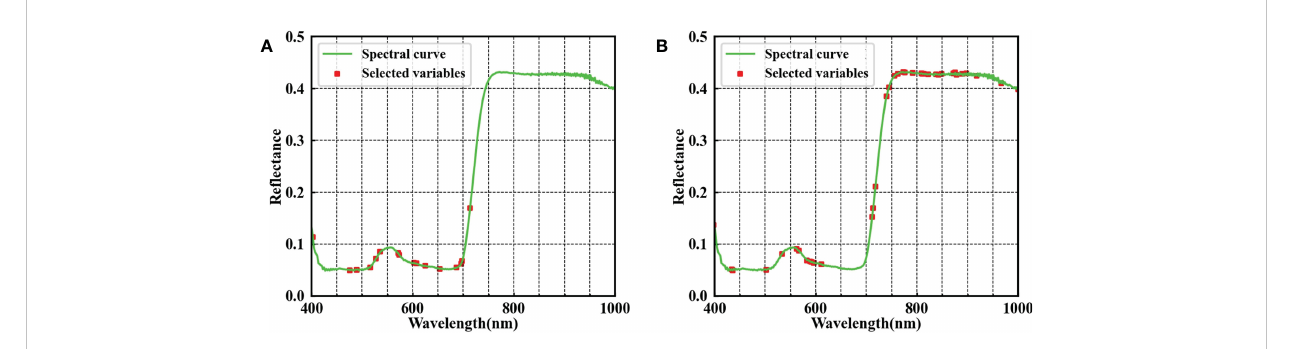
FIGURE 5 EWs selected by the GA of young (A) and mature (B)